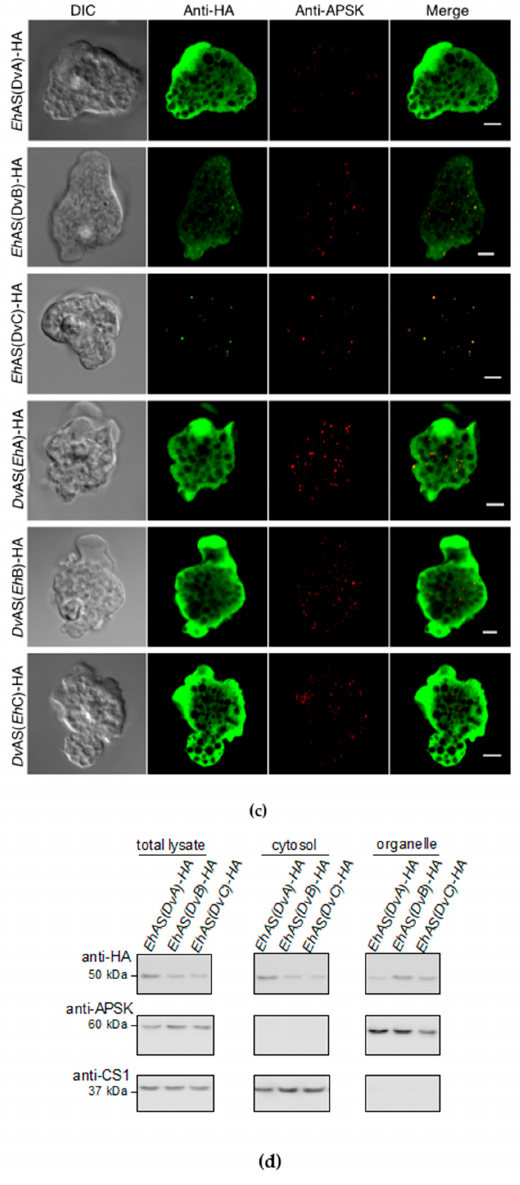
Figure 2. ( a ) Three-dimensional structure of Eh AS based on the alignment with AS from Penicillium chrysogenum were prepared with UCSF Chimera [35]. Ribbons depicting the three blocks A, B, and C are colored in red, blue, and green, respectively; ( b ) Amino acid sequence alignment of Eh AS and Dv AS using Clustal W [36] with the default parameters. The three major blocks A, B, and C are depicted in red, blue, and green text, respectively. Specific regions in block A and B are highlighted in yellow. Dv AS16–37 together with the corresponding Eh AS sequence is denoted with a dotted box to di ff erentiate it from the overlap with Dv AS1–37; ( c ) Representative immunofluorescence assay (IFA) micrographs of chimeric Eh AS( Dv A)-HA, Eh AS( Dv B)-HA, Eh AS( Dv C)-HA, Dv AS( Eh A)-HA, Dv AS( Eh B)-HA, and Dv AS( Eh C)-HA expressed in E. histolytica trophozoites, double stained with anti-HA antibody (green) and anti-APSK antiserum (red) respectively. Scale bar, 5 µ m; ( d ) Immunoblotting profiles of the total lysate, cytosol, and organelle fractions of chimeric Eh AS( Dv A)-HA, Eh AS( Dv B)-HA, and Eh AS( DvC )-HA, respectively. Membranes were stained with anti-HA antibody (top panel), anti-APSK (organelle marker, middle panel), and anti-CS1 antisera (cytosol marker, bottom panel),